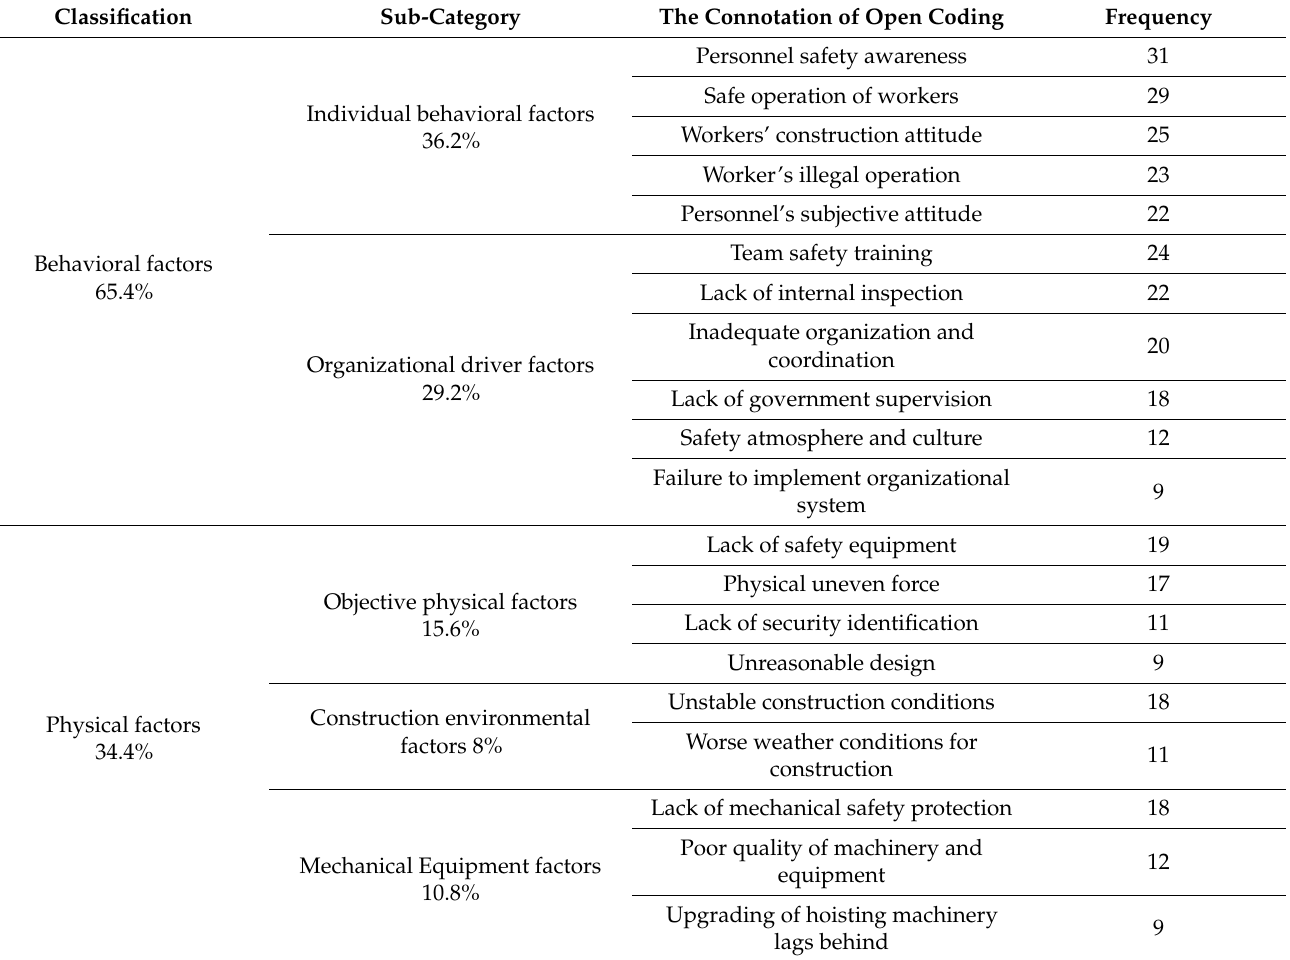
Table 3. The indicator system of precursors for construction